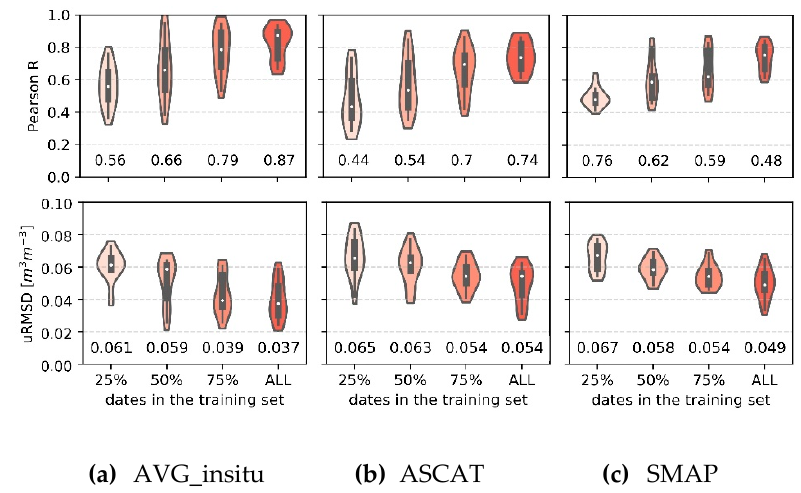
Figure 11. Violin plots of Pearson R (top) and uRMSD (bottom) between measured and predicted soil moisture (SSM + S + T + V) against the number of dates used to train the models. Training sets consisted of 25%, 50%, and 75% of contiguous observations sampled from the original training sets (ALL). Note that all the available sensor locations are included. For each training set size, we repeated the evaluation for 10 random permutations. The SSM source used as model predictor is displayed above each graph. The boxplots within the violins indicate quartiles and the white dots depict the median values (also reported below the violins). ( a ) AVG_insitu, ( b ) ASCAT, ( c ) SMAP